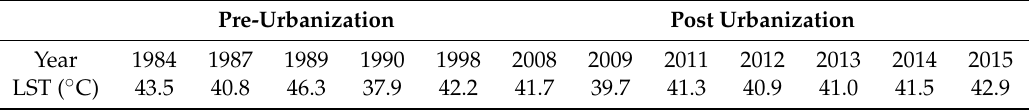
Table 10. The mean LST of current built-up areas of NT before and after